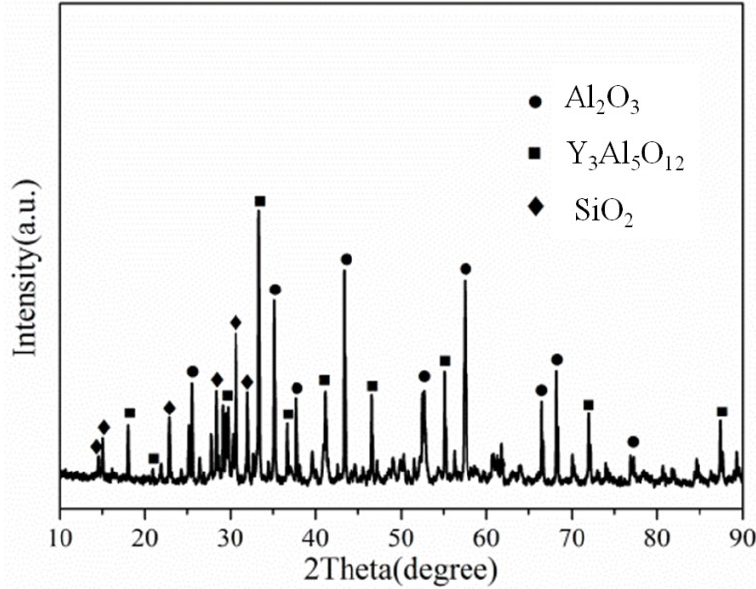
Figure 4. The XRD of interfacial reaction layer II.